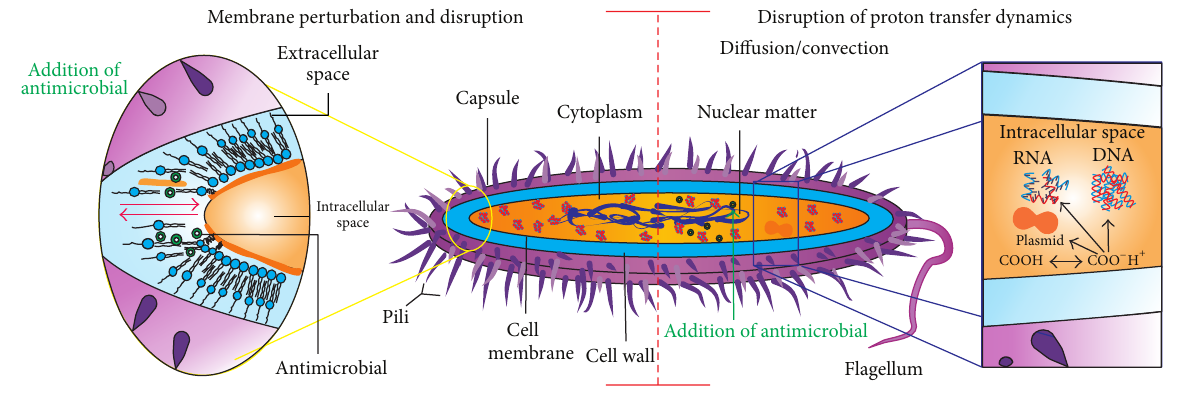
Figure 3: Mechanisms of action of